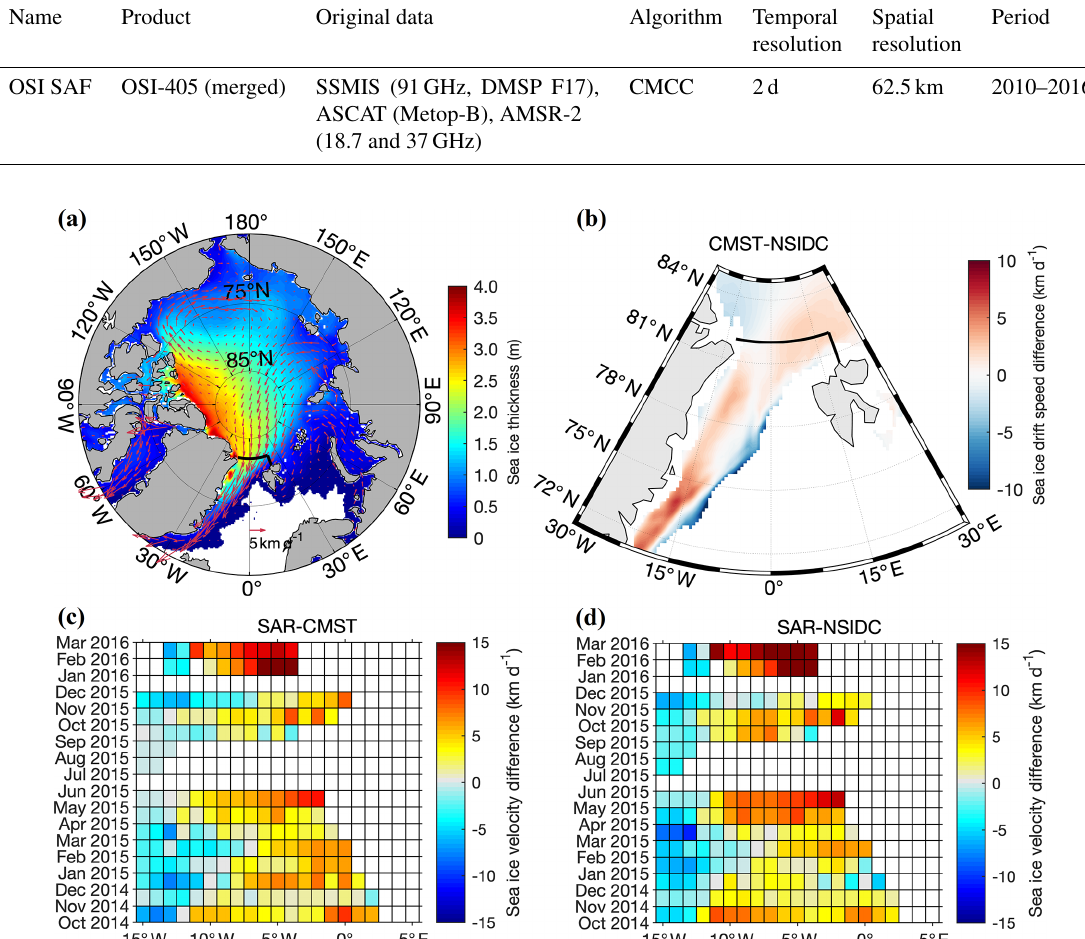
Figure 1. (a) The mean CMST sea ice drift and thickness averaged from September 2010 to December 2016. (b) The differences between CMST drift speed and NSIDC drift speed, where the background color represents the magnitudes of ice velocity difference during the same period. The thick black line represents zonal and meridional sea ice export gates to derive sea ice volume flux through the Fram Strait. (c) Meridional velocity difference between SAR drift and CMST drift at the Fram Strait (79 ◦ N). (d) Meridional velocity difference between Sentinel-1 SAR drift and NSIDC drift at the Fram Strait (79 ◦